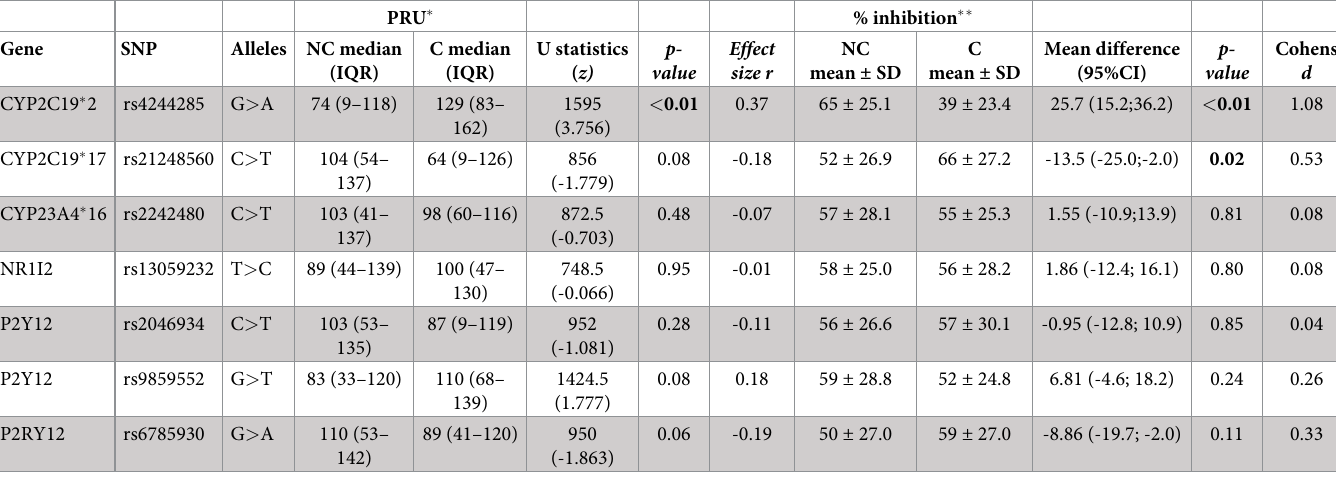
Table 3. Associations between genetic polymorpisms, platelet reactivity and % inhibition.